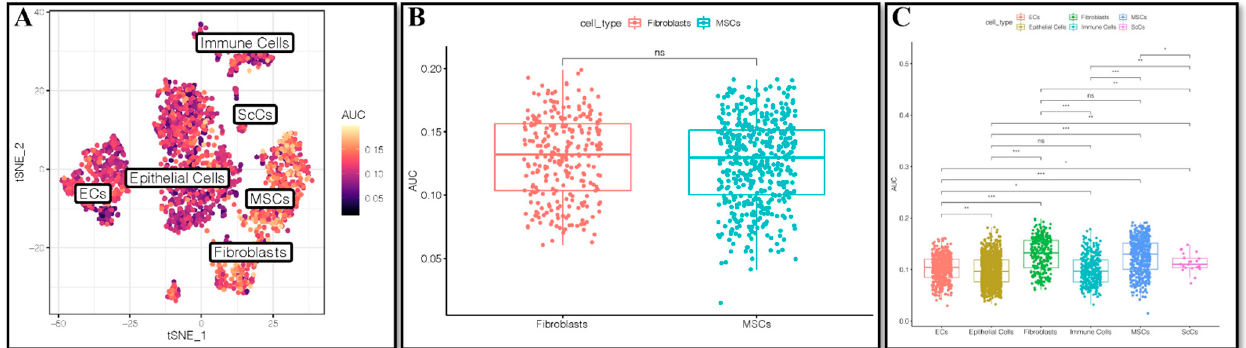
Figure 2. Activation of hypoxia in cell types. ( A ) Tsne diagram of the activation of hypoxia in cell types. ( B ) Activation of hypoxia in fibroblasts and MSCs. ( C ) Boxplots of the activation of hypoxia in cell types. * p < 0.05, ** p < 0.01, *** p < 0.001. ns, not